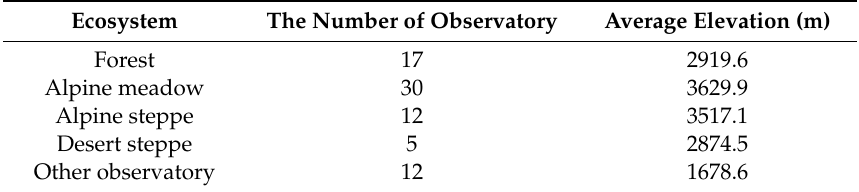
Table 1. The number and average elevation of stations in di ff erent ecosystems.